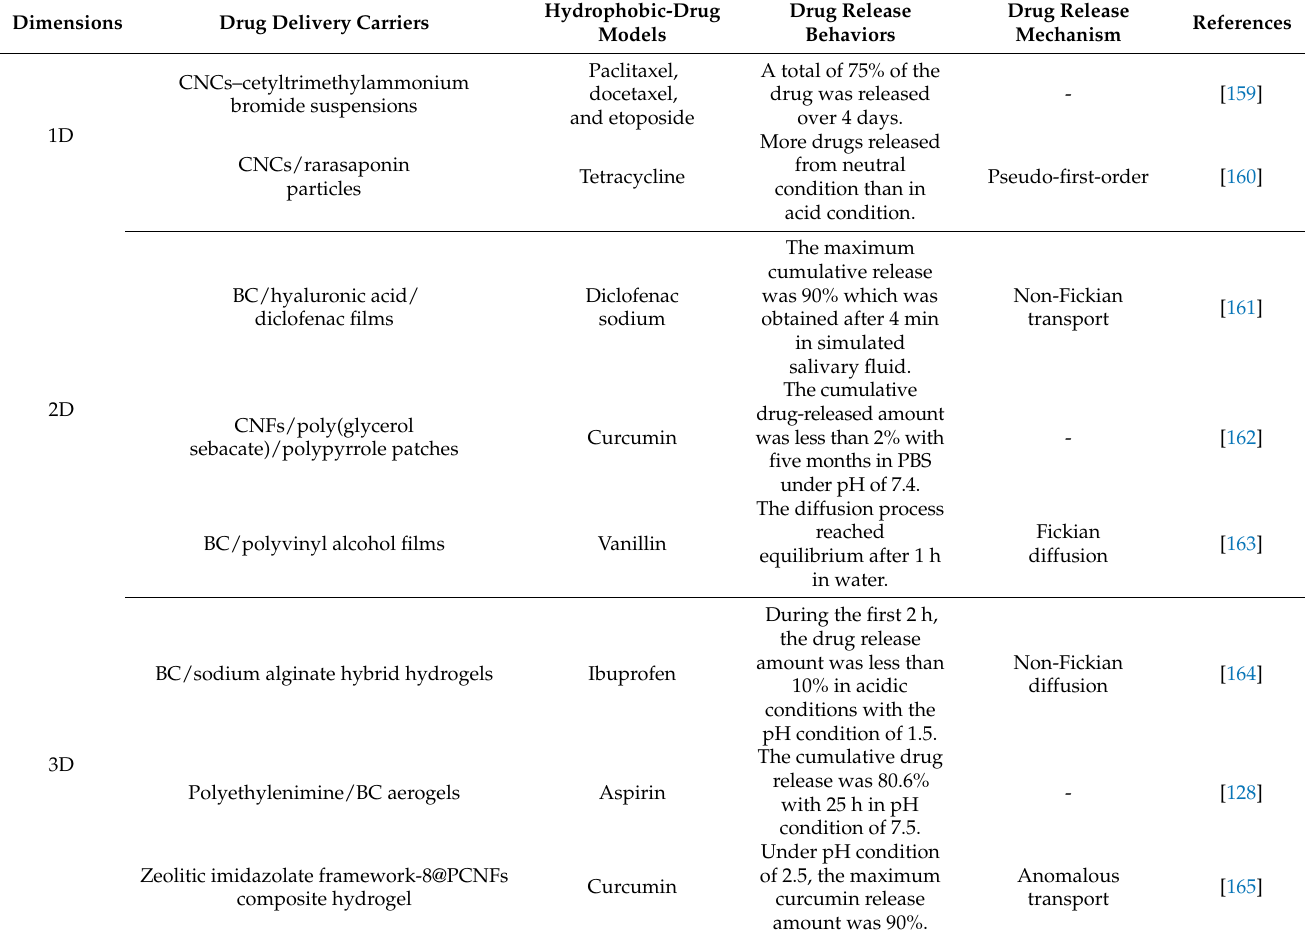
Table 3. Nanocellulose-based materials used in hydrophobic-drug delivery